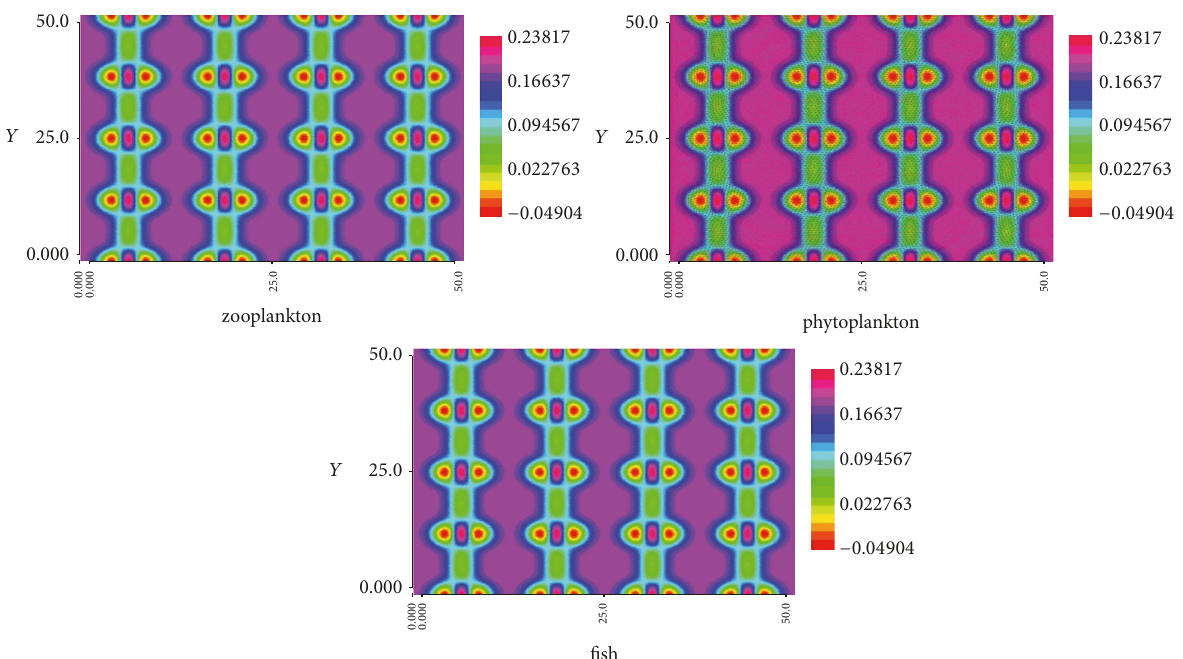
Figure 5: Spatial distribution of the system with 𝑏 0 = 0.2562 and 𝛼 0 = 0.71